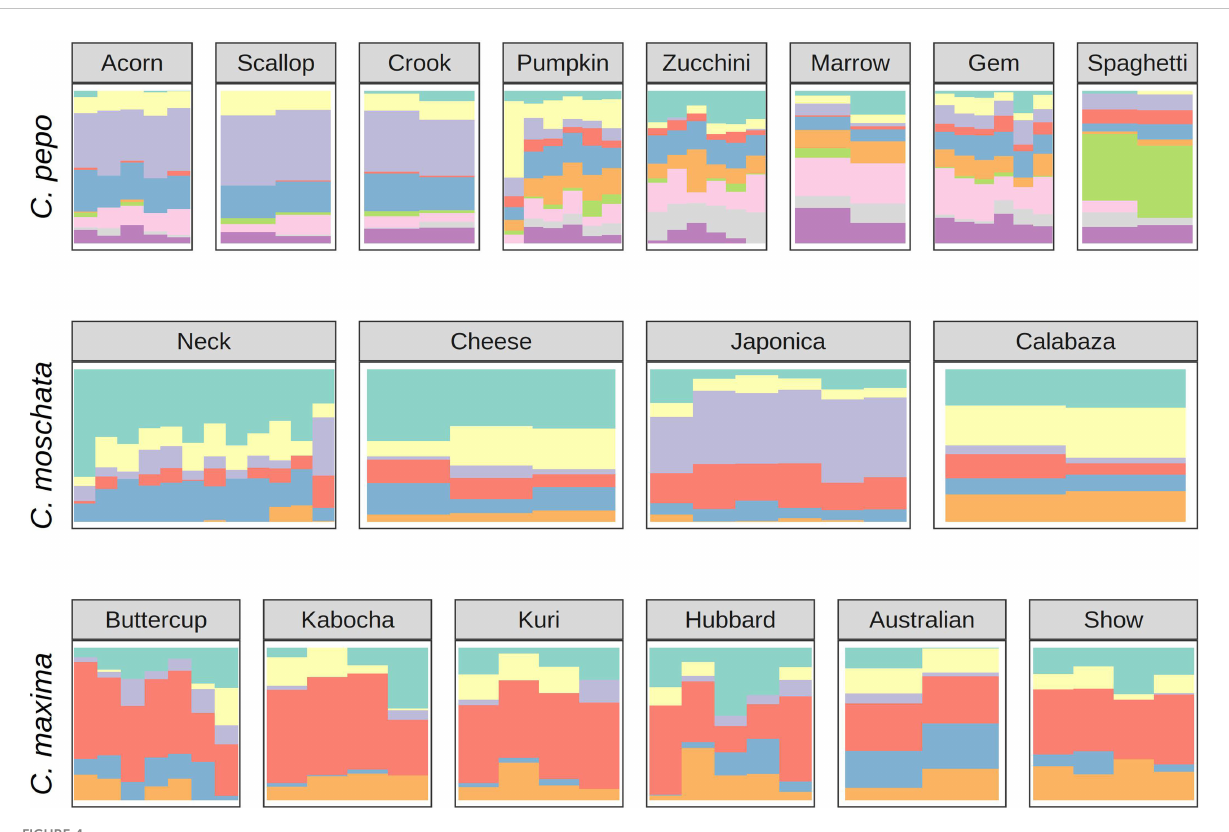
FIGURE 4 Ancestry coef fi cients projected on cultivars from each species. Results are shown grouped by market/varietal class. Colors correspond to the groups in Figure 3A.